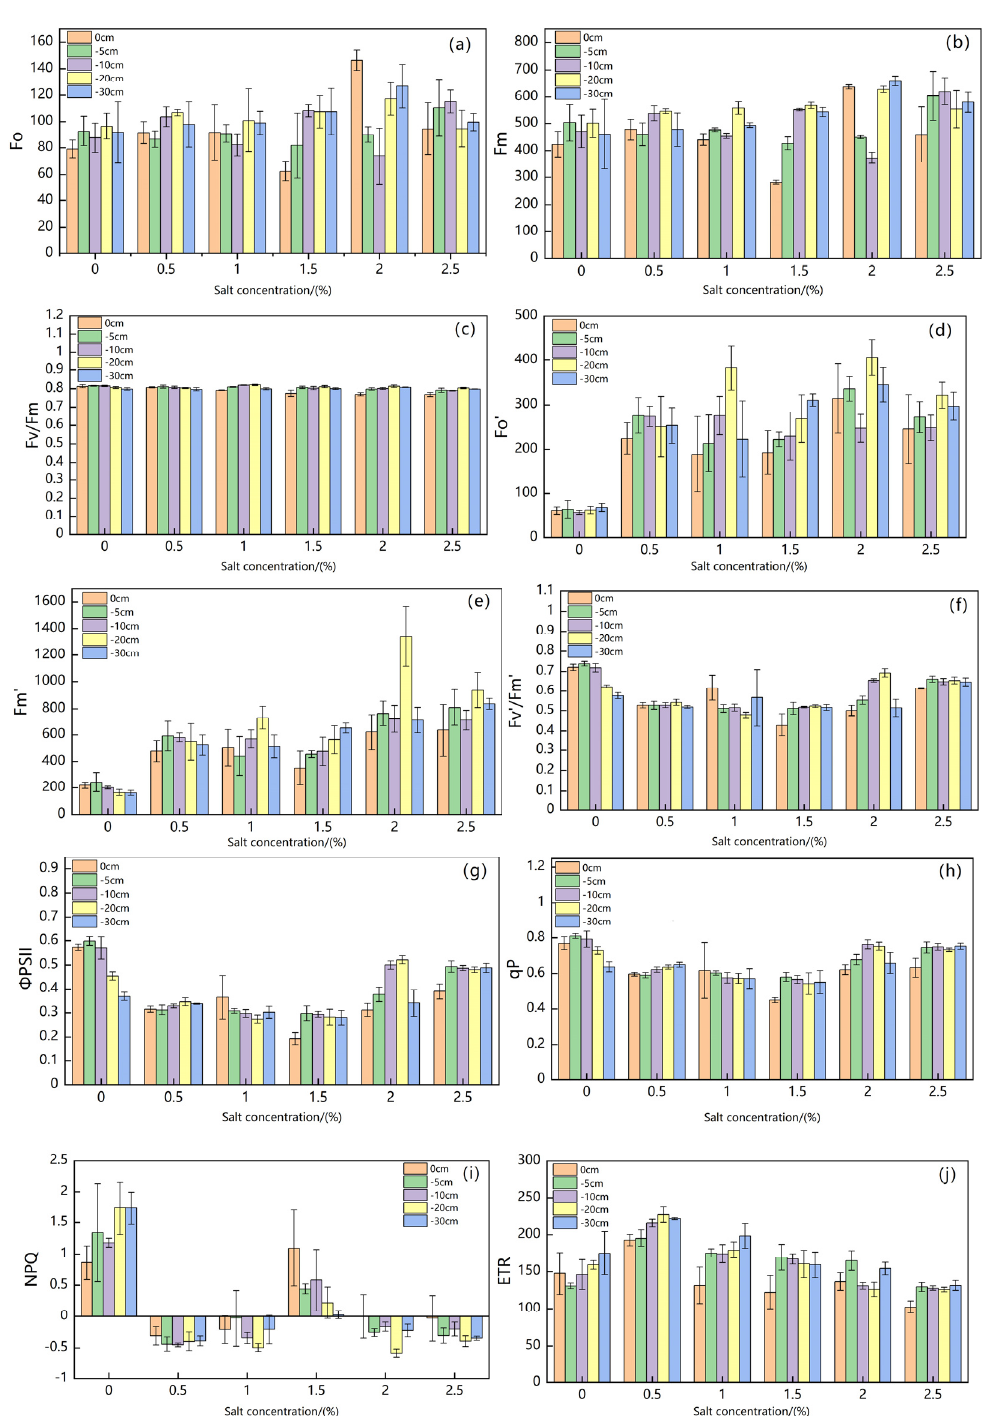
Figure 5 . Changes of Suaeda salsa Chlorophyll Fluorescence Parameters( 𝐹𝑜 ( a ) 、 𝐹𝑚 ( b ) 、 𝐹𝑣/𝐹𝑚 ( c ) 、 Figure 5. Changes of Suaeda salsa Chlorophyll Fluorescence Parameters ( Fo ( a ), Fm ( b ), Fv / Fm ( c ), Fo (cid:48) ( d ), Fm (cid:48) ( e ), Fv (cid:48) / Fm (cid:48) 𝐹𝑜’ ( d ) 、 𝐹𝑚’ ( e ) 、 𝐹𝑣’/𝐹𝑚’ ( f ) 、 𝛷𝑃𝑆𝐼𝐼 ( g ) 、 𝑞𝑃 ( h ) 、 𝑁𝑃𝑄 ( i ) 、 𝐸𝑇𝑅 ( j )) under Different Groundwater ( f ), Φ PSII ( g ) , qP ( h ), NPQ ( i ), ETR ( j )) under Different Groundwater Levels and Different Salt Levels and Different Salt Concentrations .